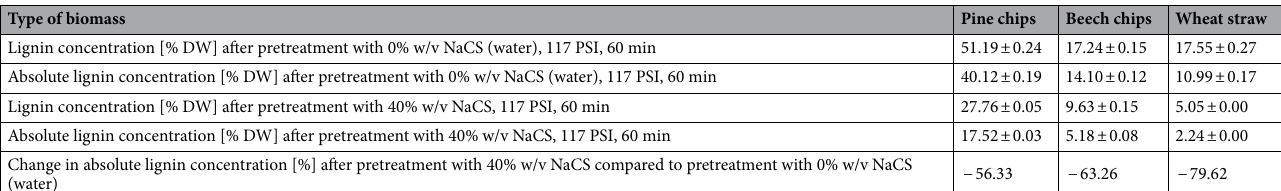
Table 5. Lignin concentration in various types of biomass after microwave-assisted pretreatment with water (0% w/v NaCS) and 40% w/v NaCS.